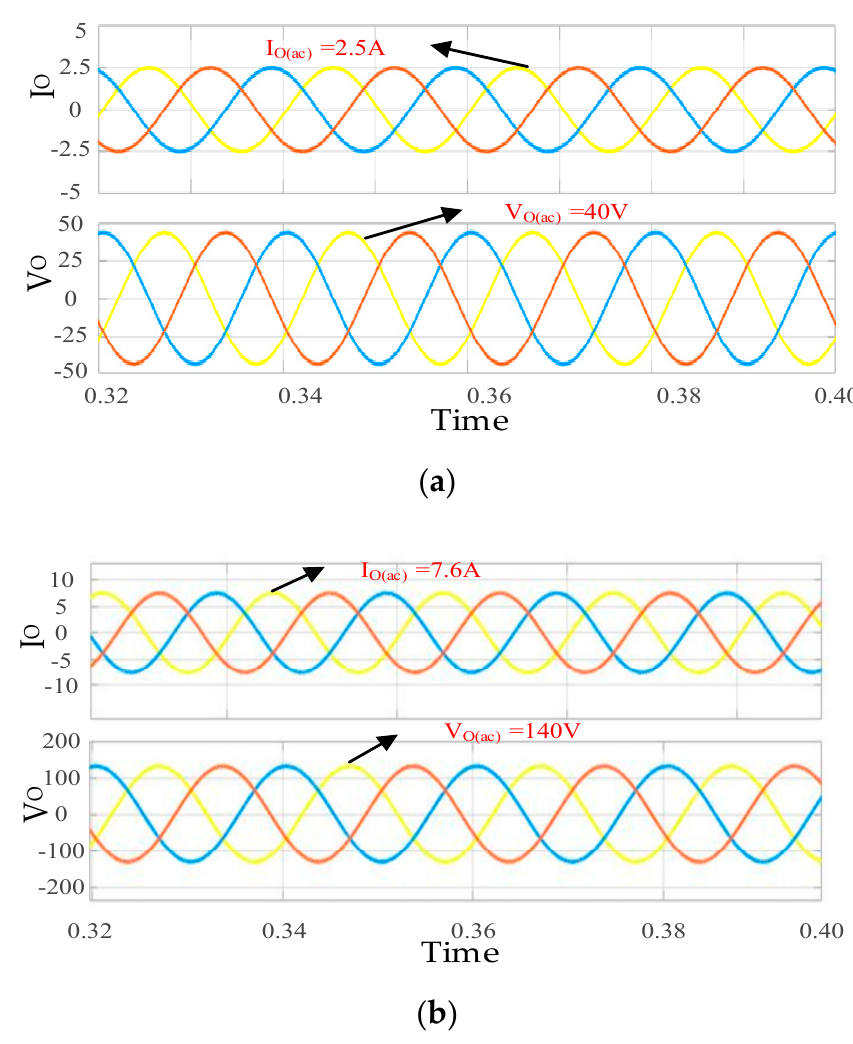
Figure 10. The output voltage and current waveforms of the 3-phase H-bridge inverter with ZSC and HS-SZSC; ( a ) conventional ZSC and ( b ) proposed HS-SZSC.